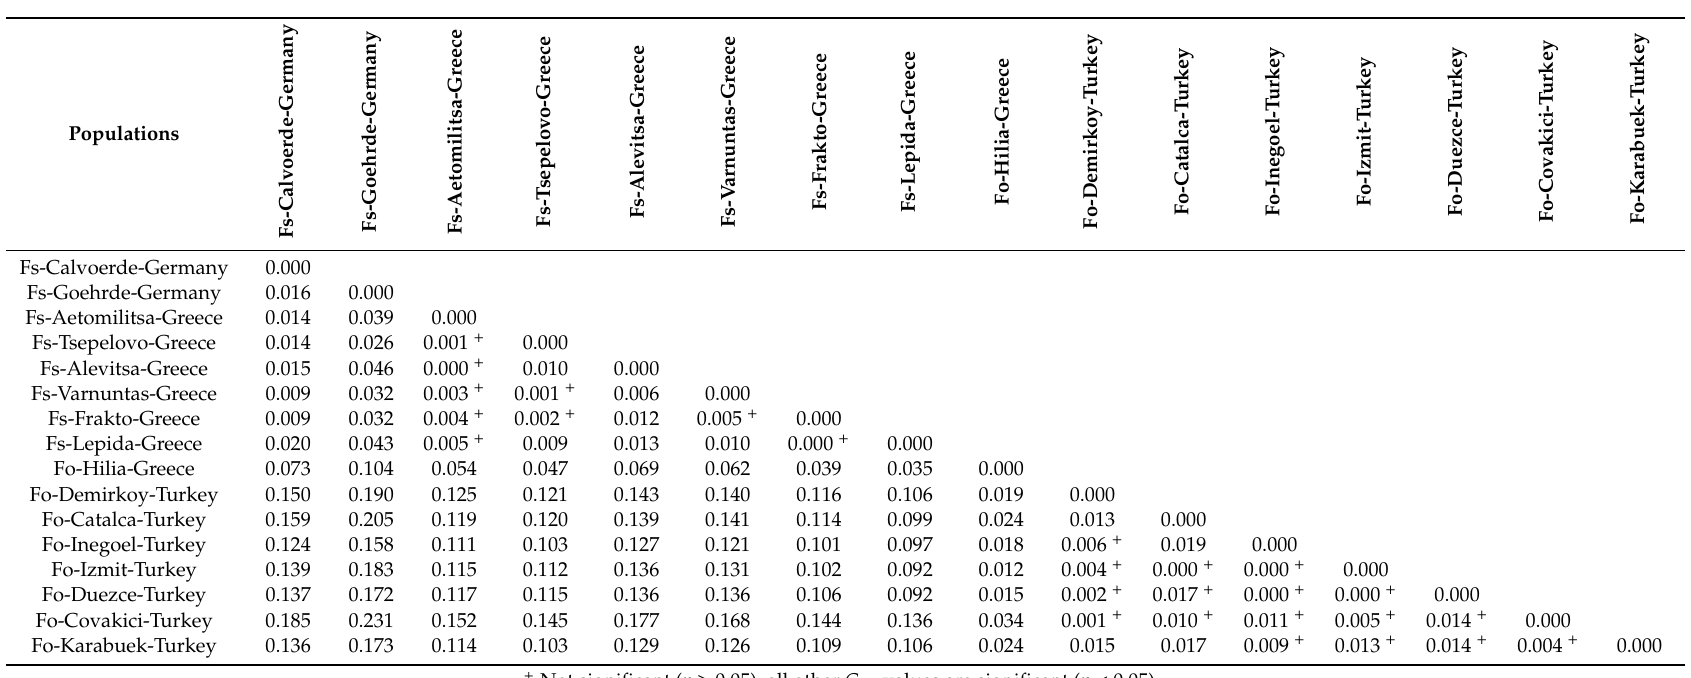
Table 4. Pairwise G ST values between